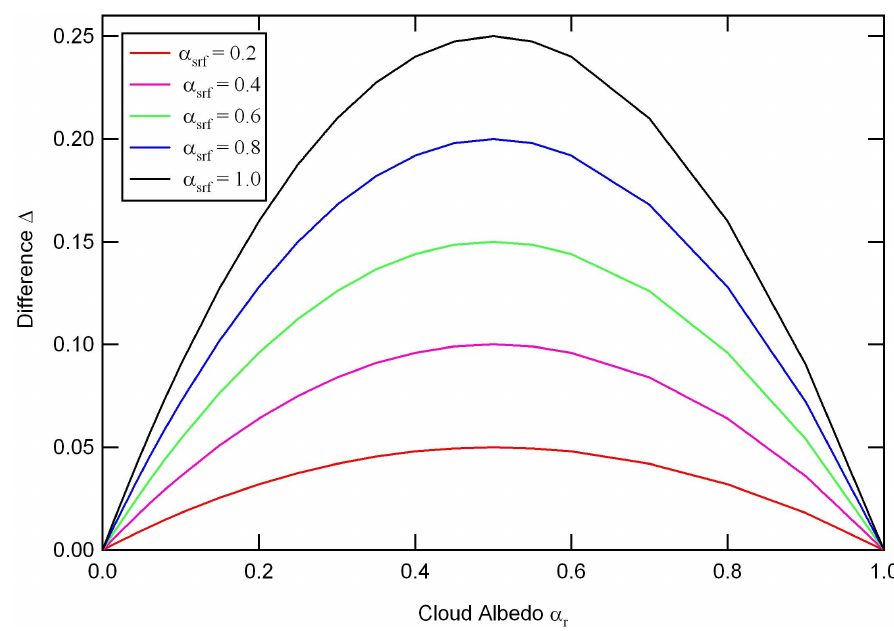
Fig. 7. Dependence of the difference 1 on cloud albedo for different values of surface